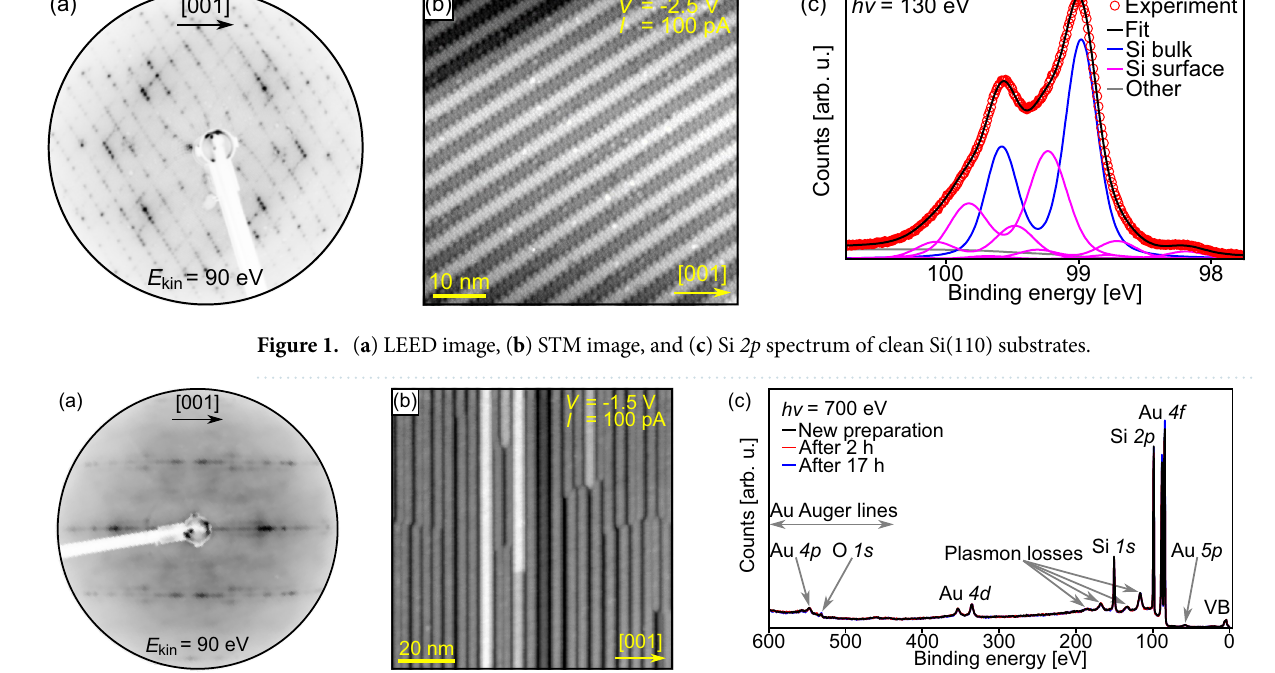
Figure 2. ( a ) LEED image, ( b ) STM image, and ( c ) survey PES spectra of Au silicide nanowire preparations. The nanowires were prepared by depositing about 1.0 ML Au on a clean Si(110) substrate at room temperature followed by annealing at 600 ◦ C for 2 min